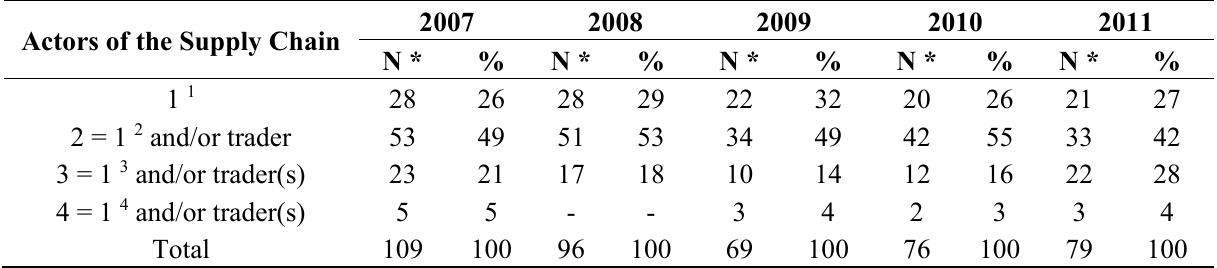
Table 4. Supply chains according to number of actors involved